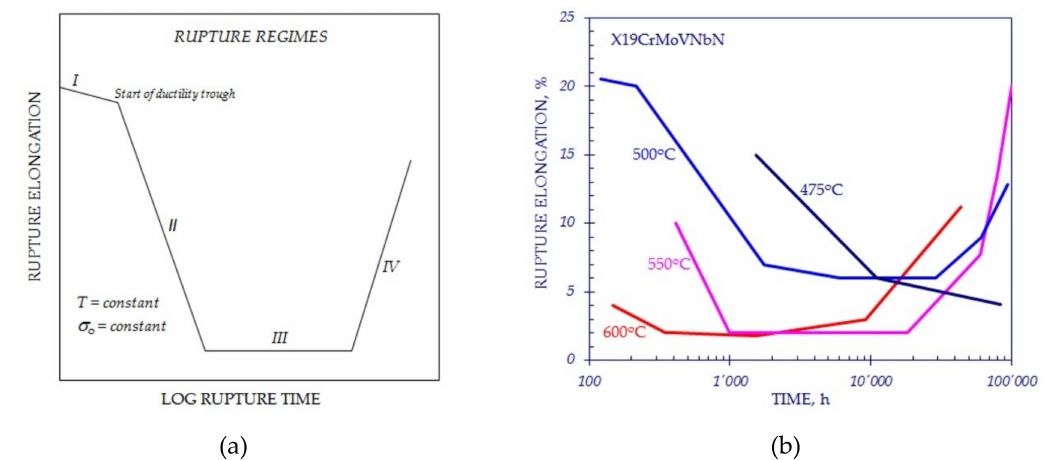
Figure 3. ( a ) Schematic representation of sequence of creep-rupture regimes for ferritic steels, and ( b ) experimental evidence of the influence of temperature on kinetics of creep-rupture regime development (data mainly available for regimes II, III and